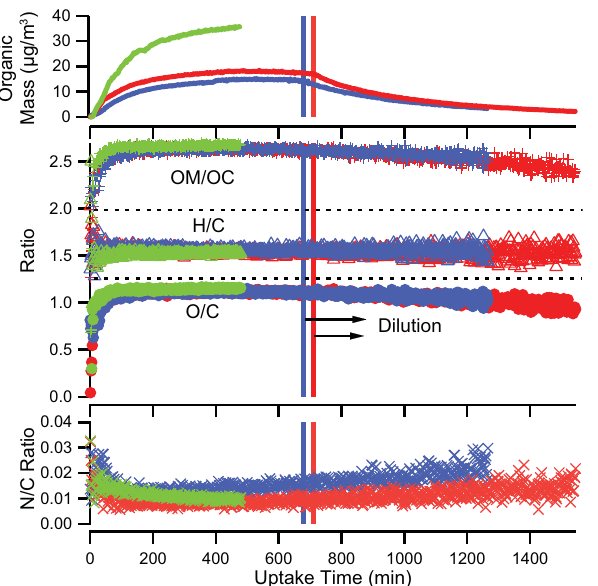
Fig. 1. Experimental profile of AMS organic mass (not corrected for collection efficiency), elemental ratios and OM/OC for glyoxal uptake experiments. Experiment 1 is in blue, 2 in red and 3 in green. Dotted lines are provided to visually separate different ratios.